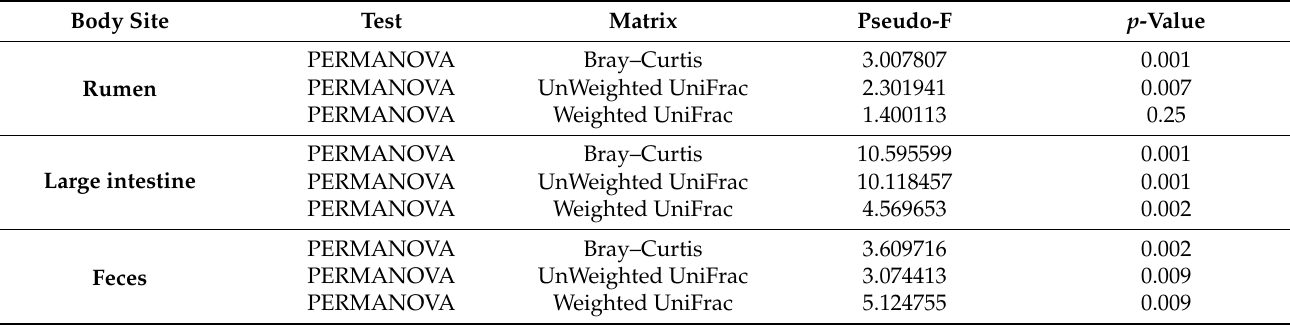
Table 4. Beta diversity analysis of GIT microbiota characterized in traditional vs. alternatively fed animals. Body